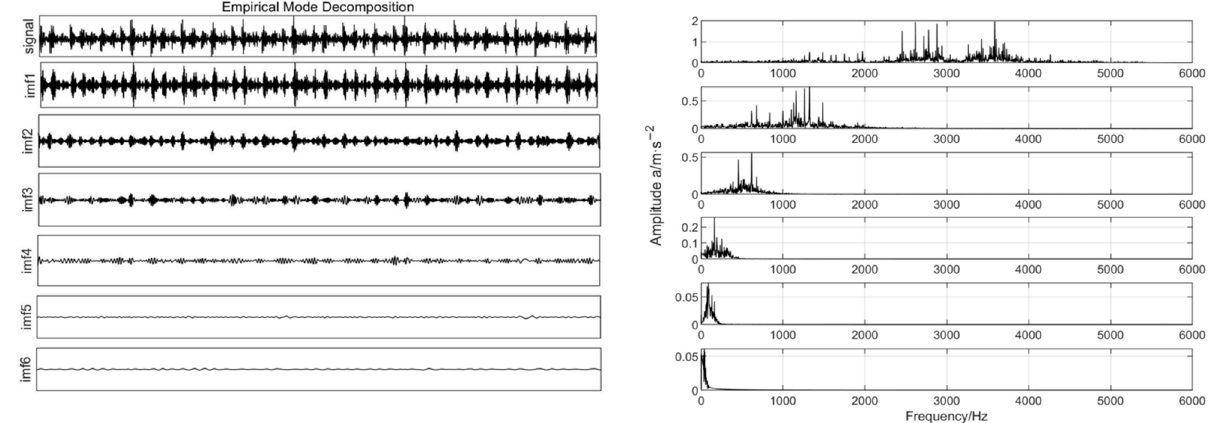
Figure 10. Time domain and frequency domain diagrams of IMF components decomposed by IGVMD.